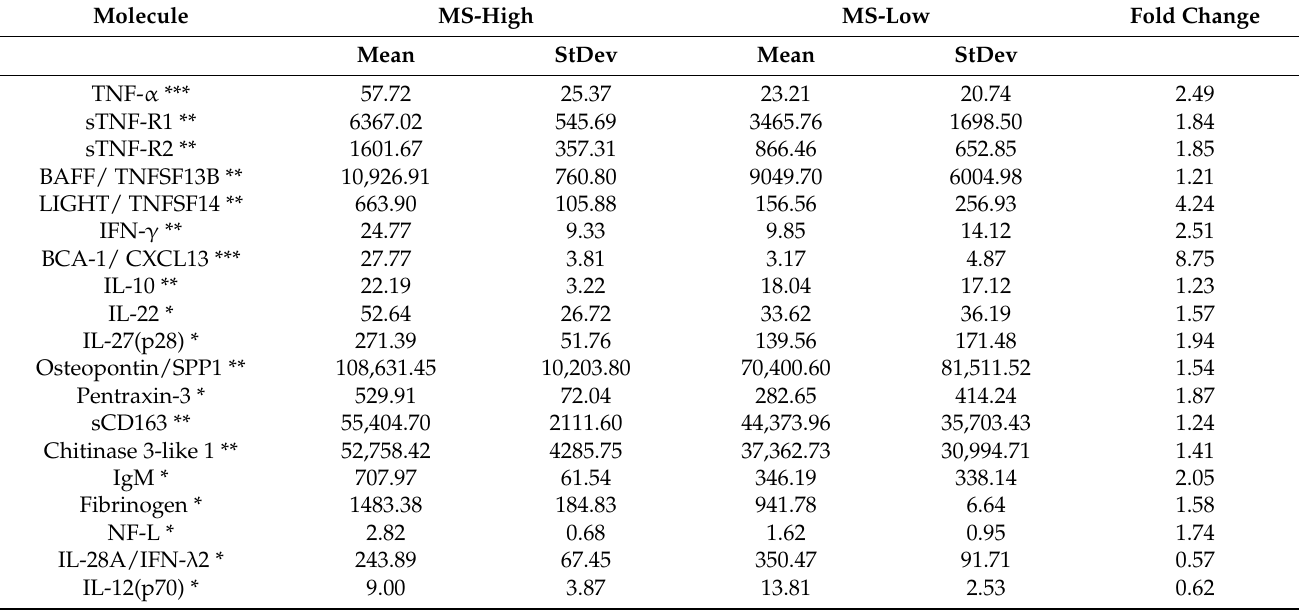
Table 2. CSF inflammatory pattern associated with differential cortical lesion load.